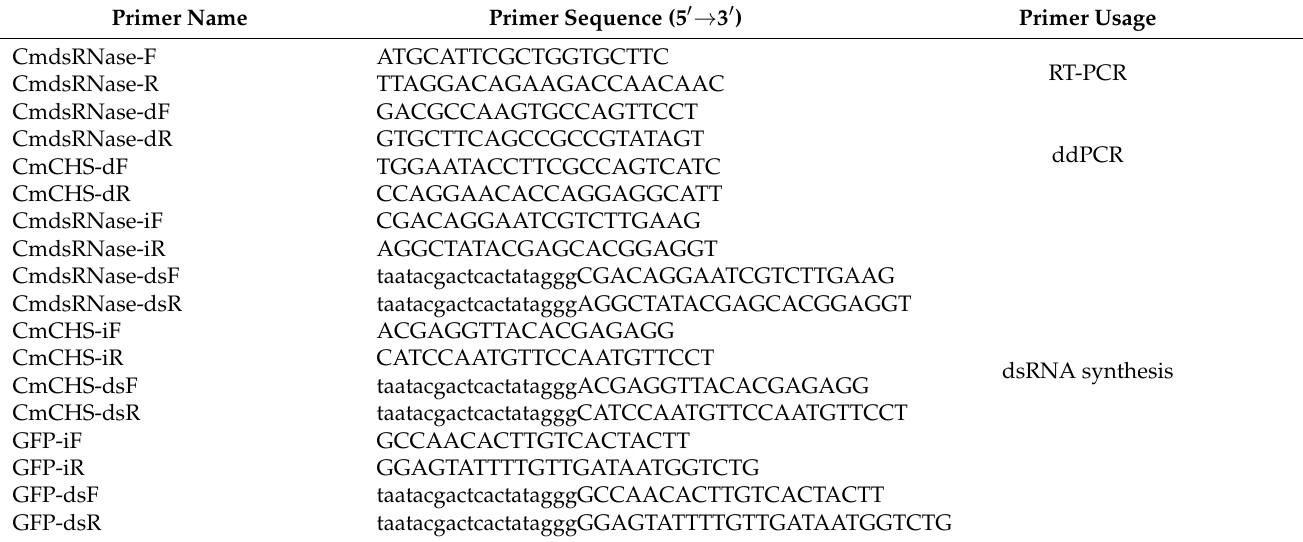
Table 2. Primers used for cloning and expression analysis of CmdsRNase from C. medinalis